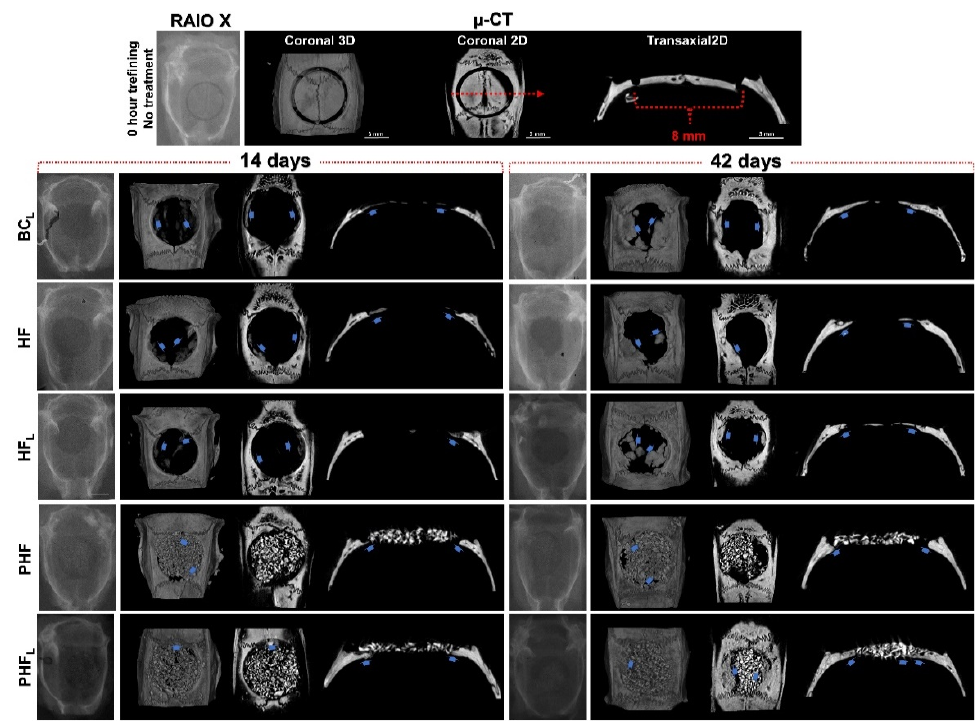
Figure 1. Radiographic (one-dimensional images) and computed microtomographic images (two- dimensional — top view and three-dimensional in coronal and transaxial sections) of rat calvaria bone defects at 14 and 42 days after osteotomy. ( n = 12/group): BC L : defect filled by blood clot and laser photobiomodulation therapy; HF: defect filled by heterologous fibrin biopolymer; HF L defect filled by heterologous fibrin biopolymer and laser photobiomodulation therapy; PHF: defect filled by deproteinized bovine bone particles incorporated into heterologous fibrin biopolymer; PHF L : defect filled by deproteinized bovine bone particles incorporated into heterologous fibrin biopolymer and laser photobiomodulation therapy. At 14 days, in BC L , HF and HF L , note discrete radiopacity of the defect margins vs. remaining bone suggesting moderate formation of bone tissue (blue arrow) and small bone islands in the dura mater region. In PHF and PHF L , the defects present a large amount of biomaterial particles and formation of centripetal bone tissue (blue arrow), which tapers towards its central region. At 42 days, bone defects were not completely restored in any experimental group. In BC L , HF and HF L , bone formation at the edge of the defect is denser and more mature, but unable to occupy the more central regions. In PHF and PHF L , defects with the maintenance of biomaterial particles and increased bone formation around the particles, mainly in the dura mater region, compared to the previous period. µ-CT -all scaled image size 3 mm.